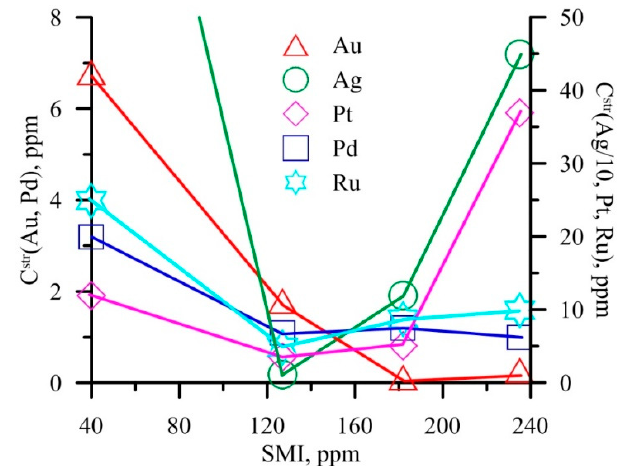
Figure 15. Structurally bound NM versus the SMI in pyrite crystals. Note the ten-fold reduced concentration scale for Ag. See Tables 4 and 5 for numerical data on NM and SMI, accordingly.